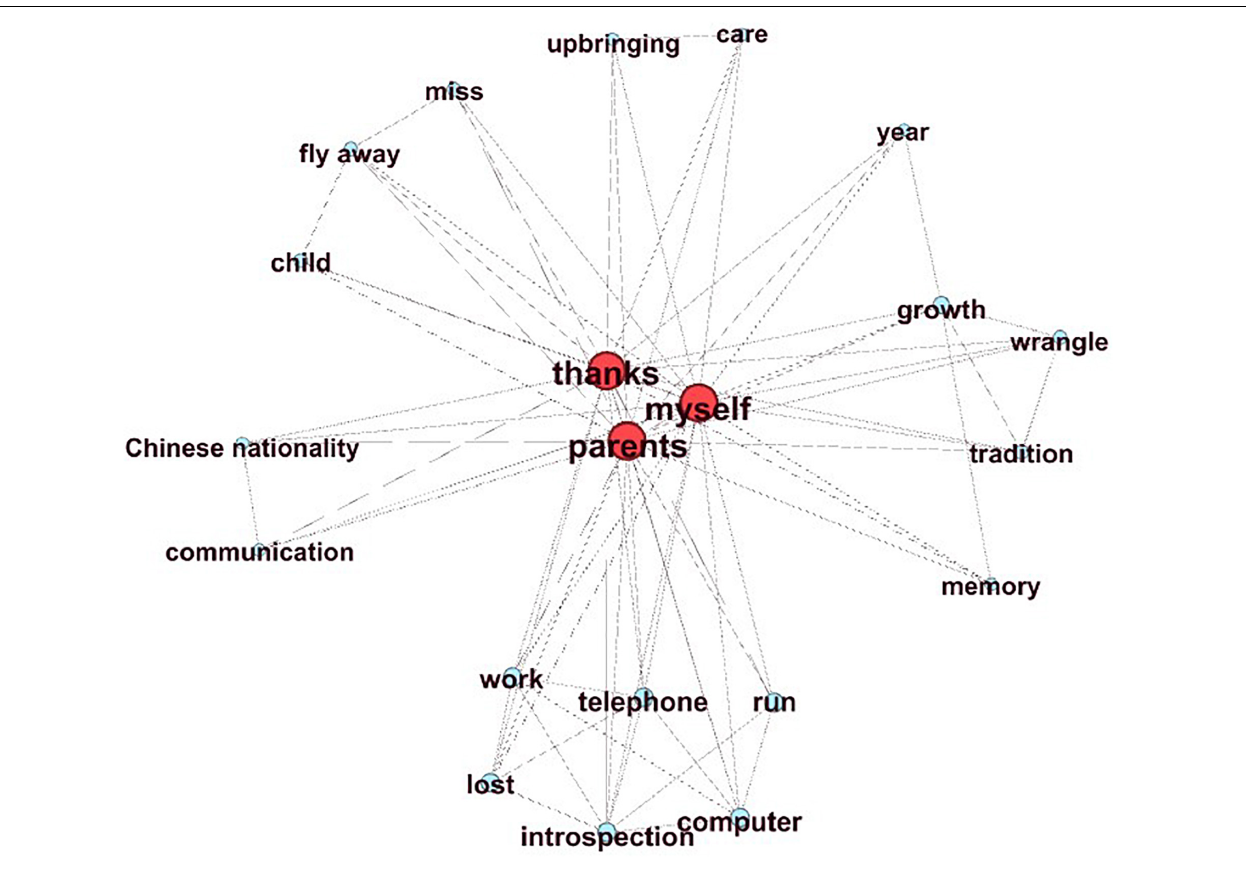
FIGURE 2 | High-level main